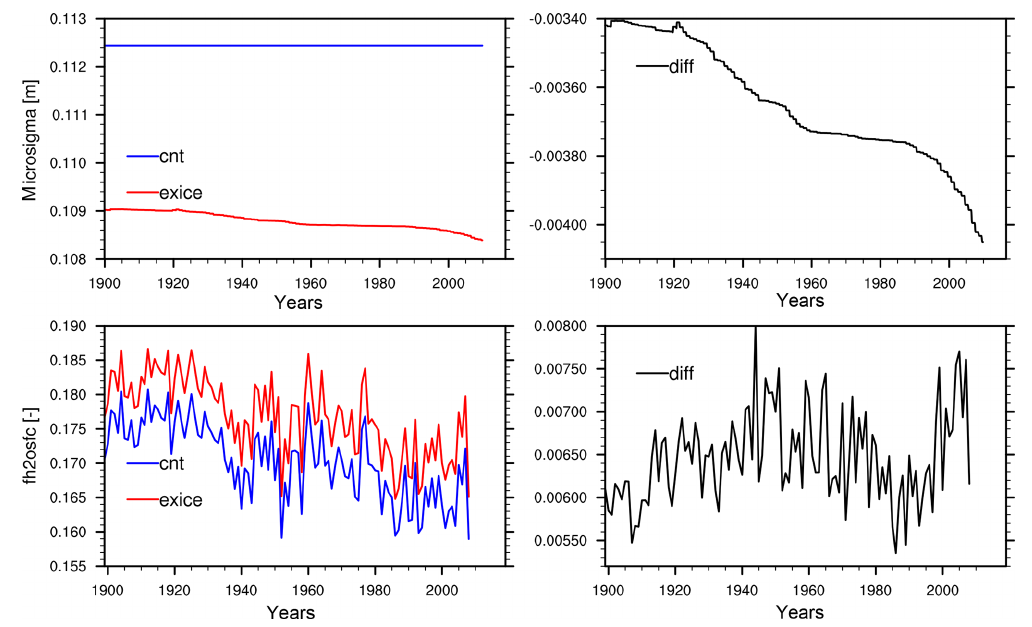
Figure 4. Time series of spatially averaged high-latitude ( > 50 ◦ N) σ micro and annual maximum f h2osfc variables from Exice and Control experiments together with the time series of the Exice–Control difference (diff) for the period 1900–2010.